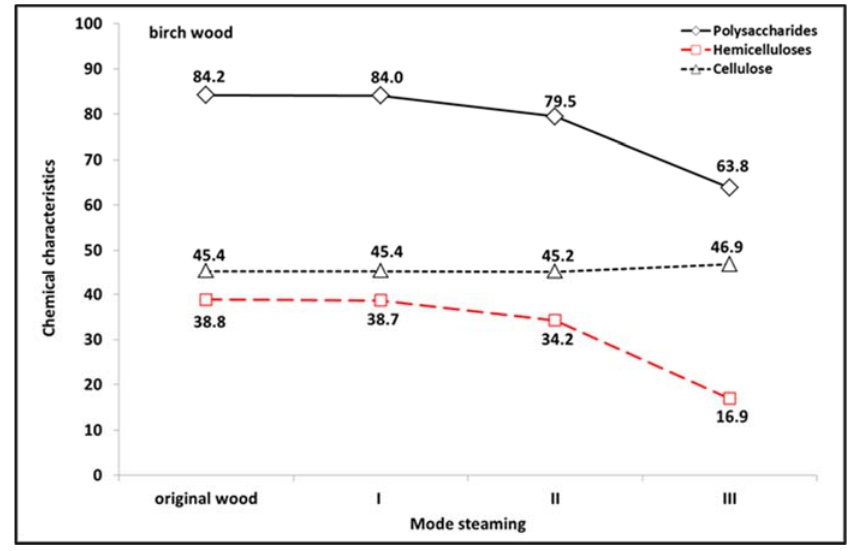
Figure 2. Changes in polysaccharide fraction of birch wood according to steaming mode.